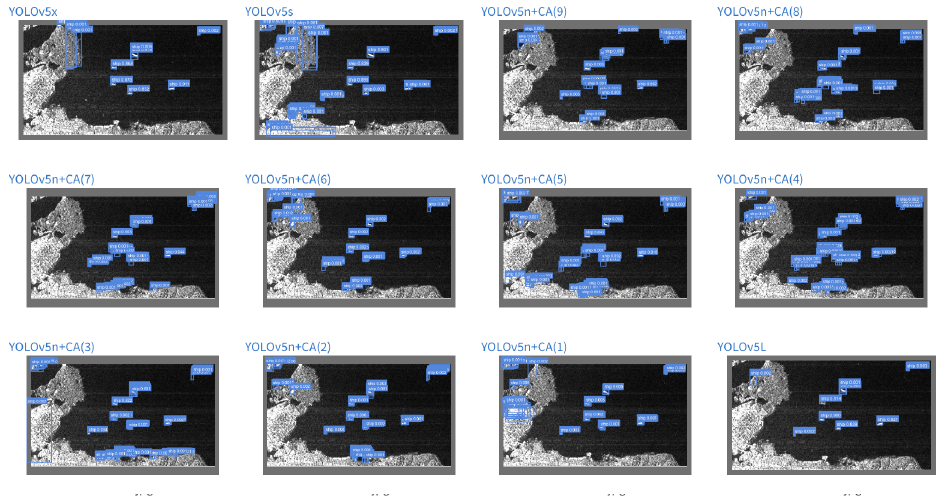
Figure 12. Visualization of a typical inshore scenario during the testing process for experiment. Each subgraph represents the Bbox generation of the scene by different models before